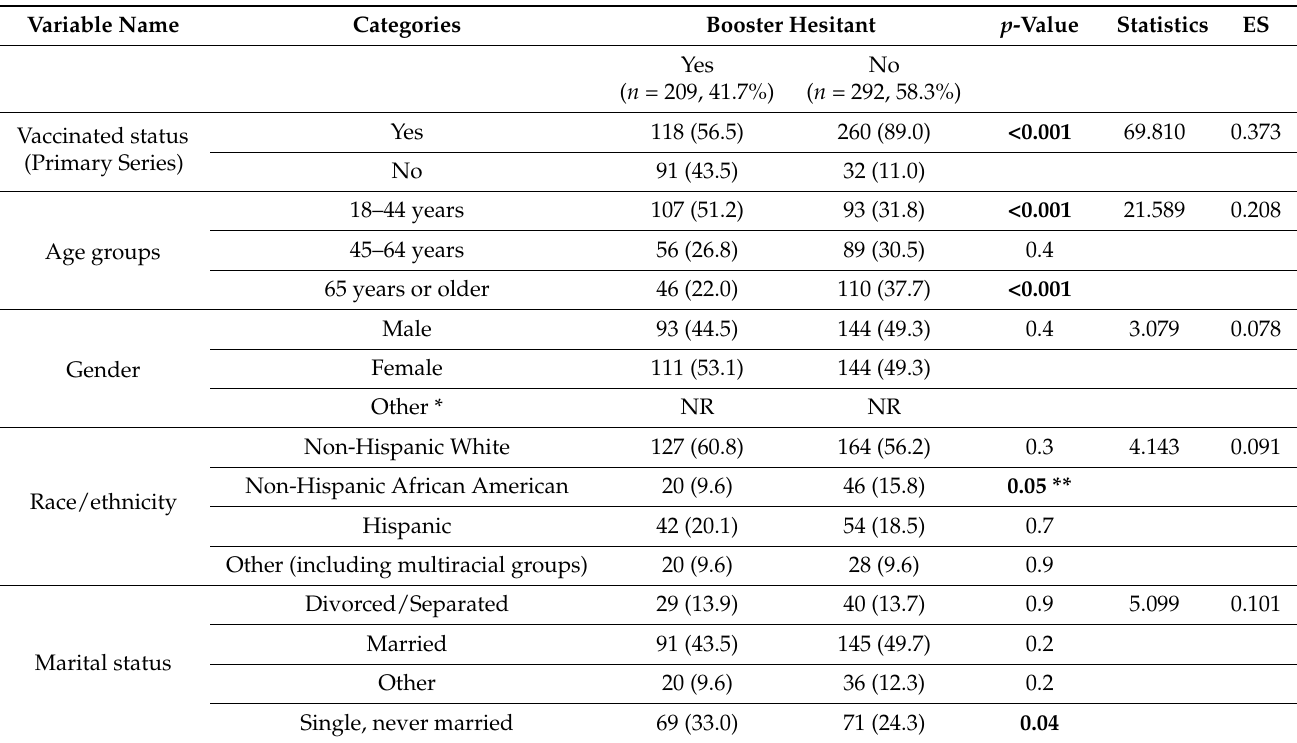
Table 2. Bivariate comparison of Booster Dose hesitancy by sample characteristics ( N =